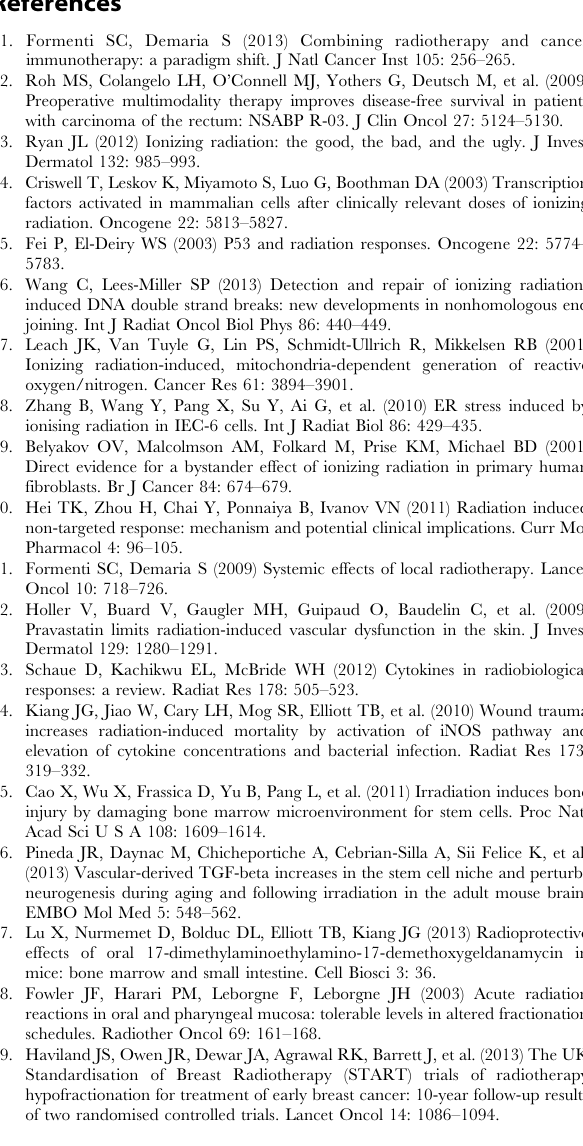
Figure S4 Quantification of molecular expression in the feather follicles. RT-PCR analysis of gene expression in the feather follicles were densitometrically quantified (for P53/P21/ Cyclin D1/Fas gene, gels were shown in Fig. 3D) and statistically